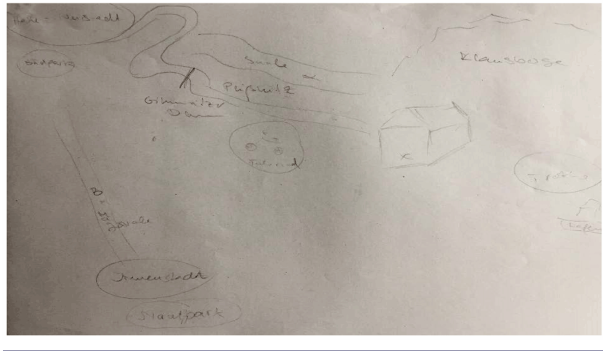
Fig. 7 . Original mental map selected from the Halle-Newtown sample (n =